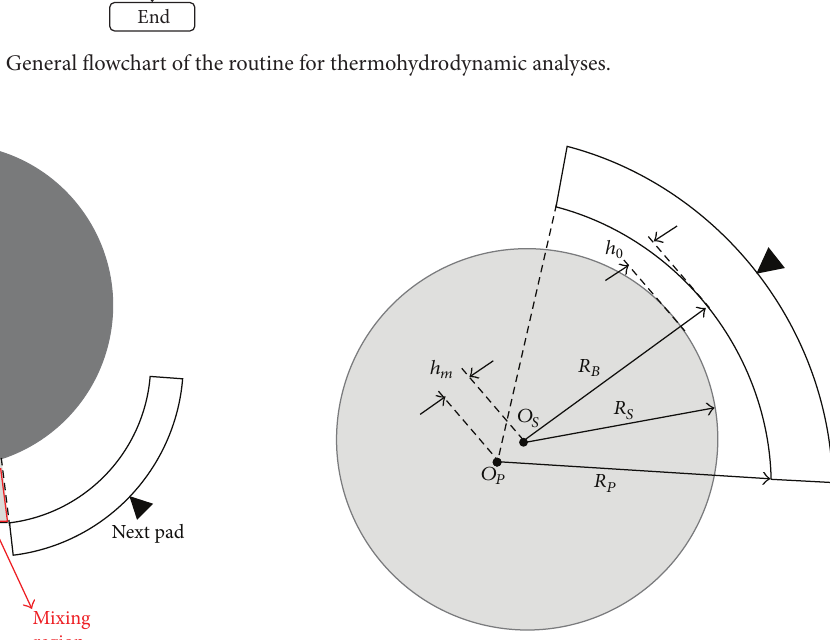
Figure 10: Mixing region between pads in the tilting pad bearings.